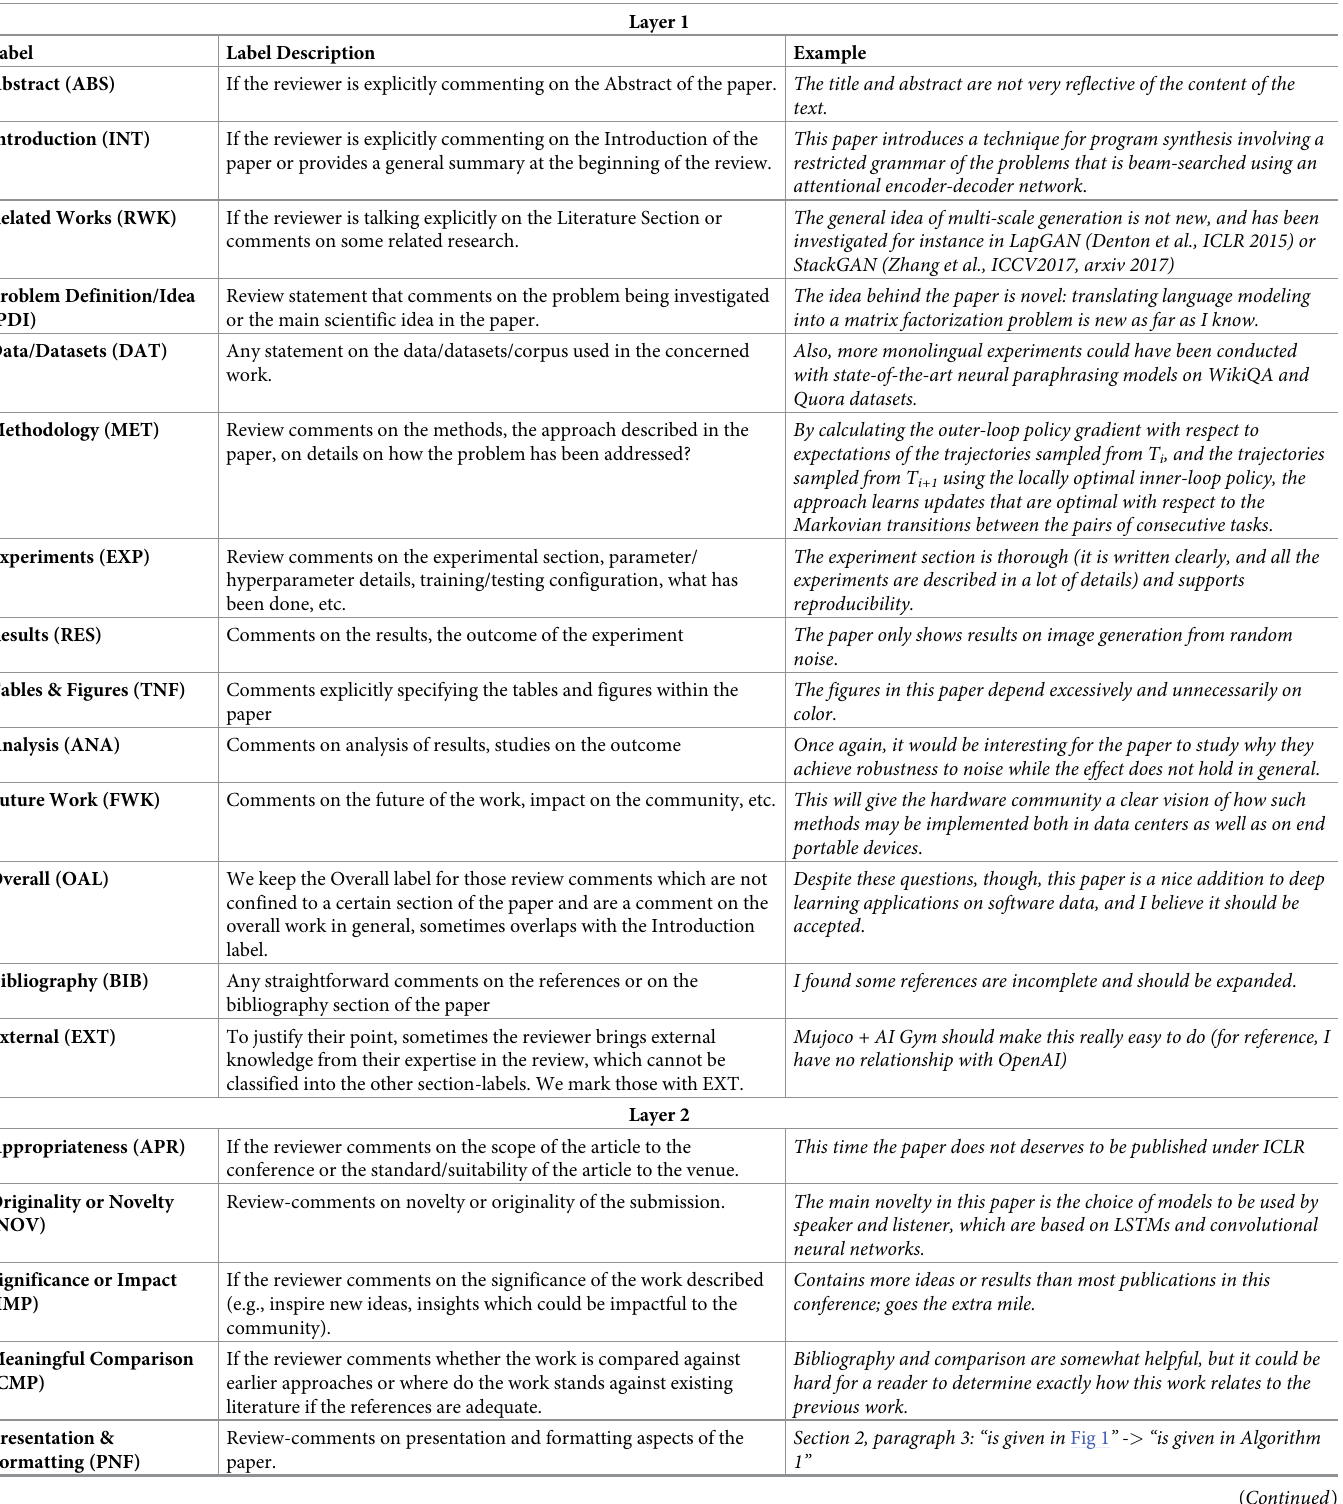
Table 2. Representative examples of review texts for different labels in Review-Paper Section Correspondence Layer (Layer 1) and review-paper aspect layer (Layer